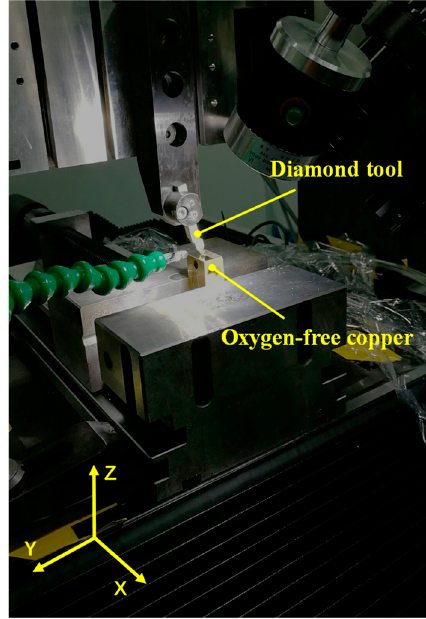
Figure 3. Diamond planing experiment. Table 1. Parameters of diamond tool and workpiece.